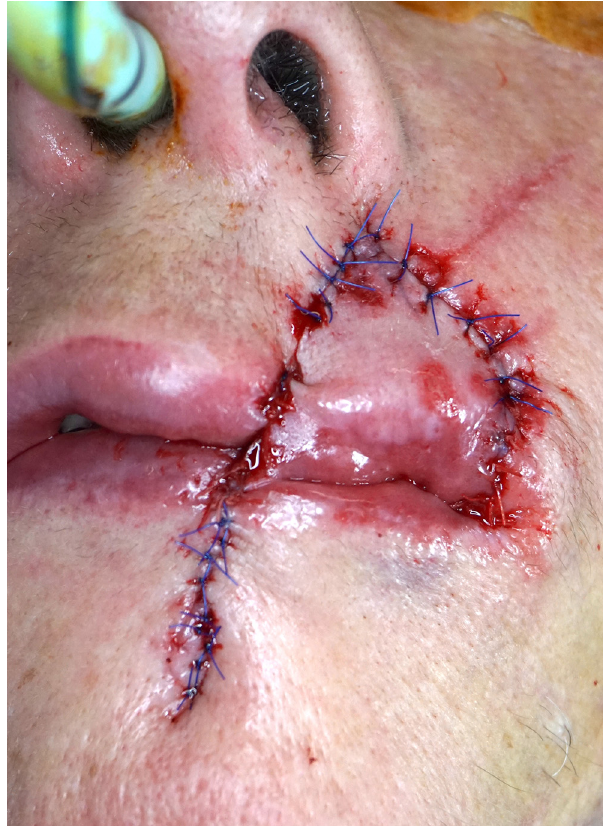
Fig. 3. At day 7, Abbe ’ s fl ap in immediate postoperative.